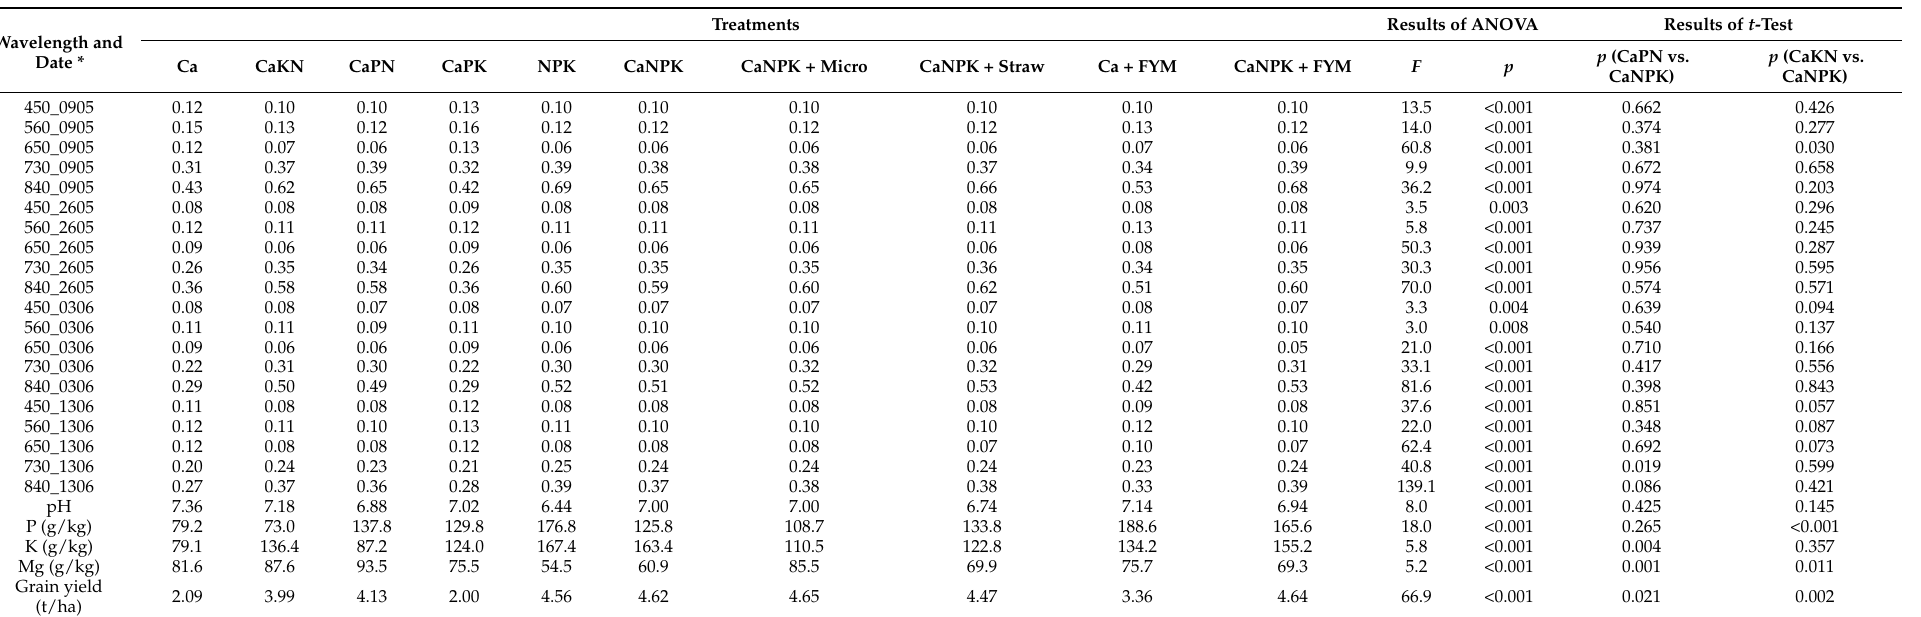
Table 6. Means for relative spectral reflectance, soil pH and available nutrients, and grain yield for the treatments in experiment 2 (monoculture of rye). Results of ANOVA and t -test for comparisons between the